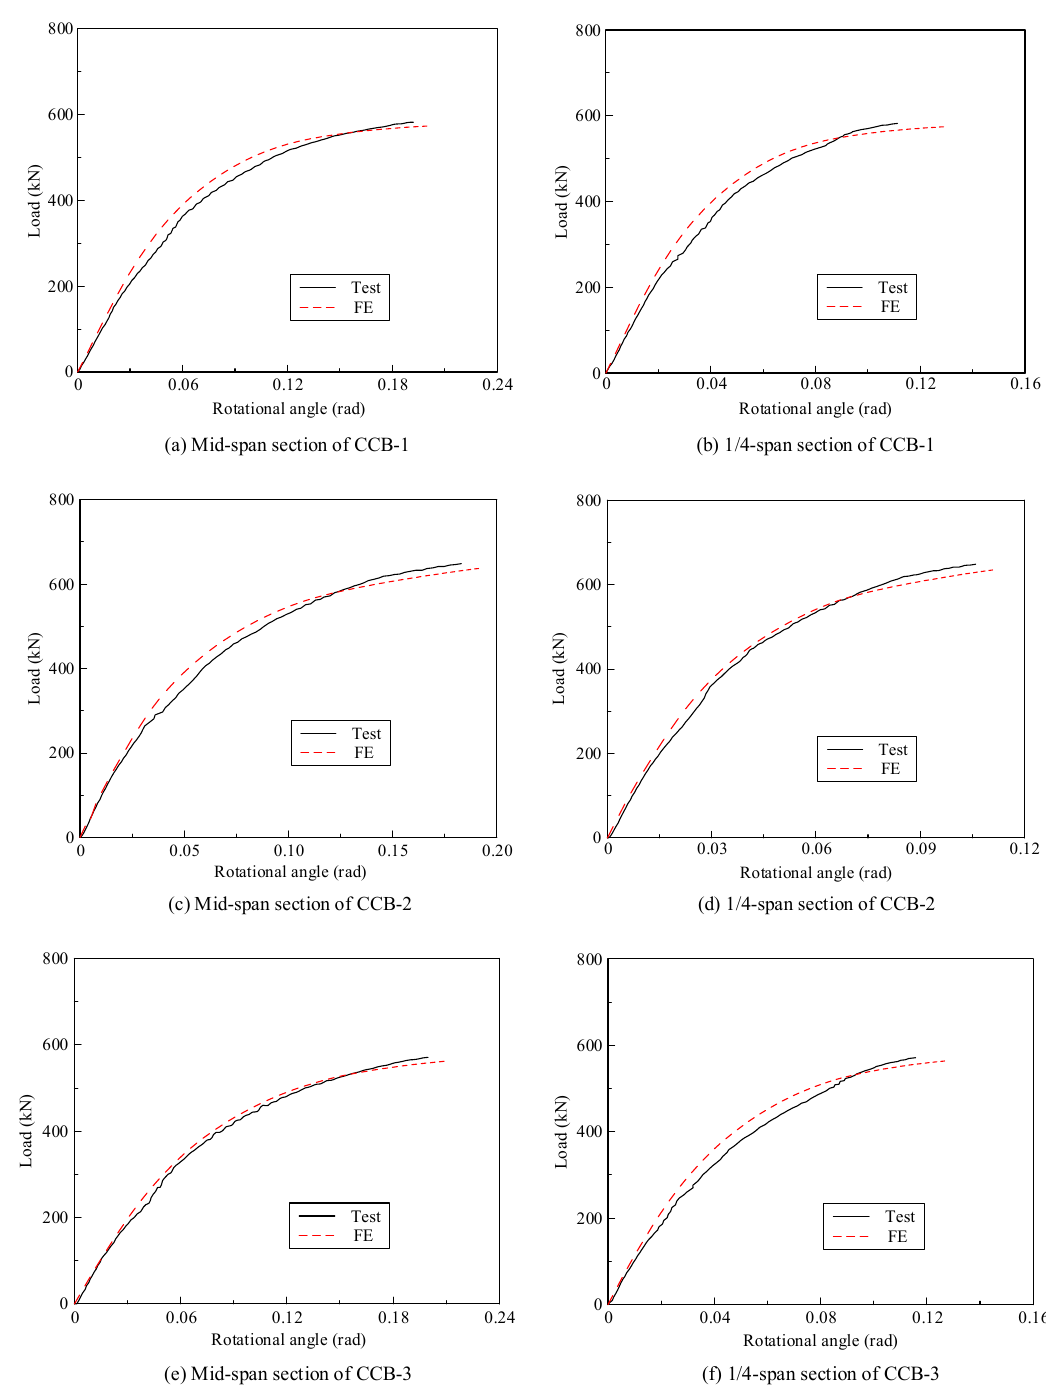
Figure 18. Comparison of the load–rotational angle curves from the test and numerical analyses.